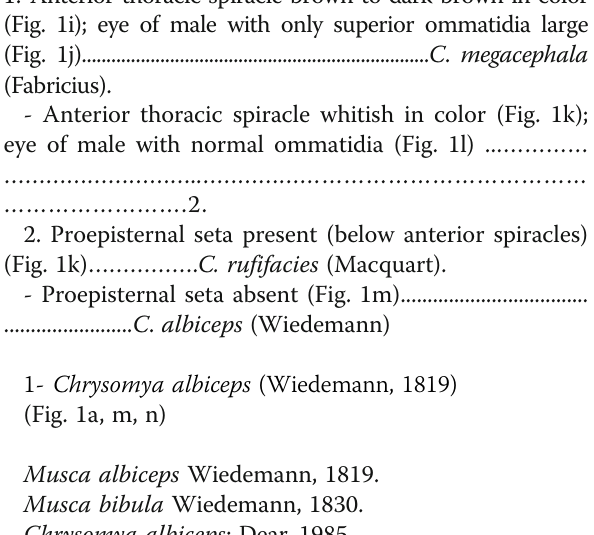
Body 6 – 12 mm in length, stout. Head large, with prom- inent red eyes. Antennae brownish in color, third anten- nal segment about 3.7 times as long as the second one, arista dark brown, long plumose. Thorax greenish blue, pronotal region with three faint short stripes; calypters white, the lower one hairy on its upper surface. Legs black. Abdomen greenish blue